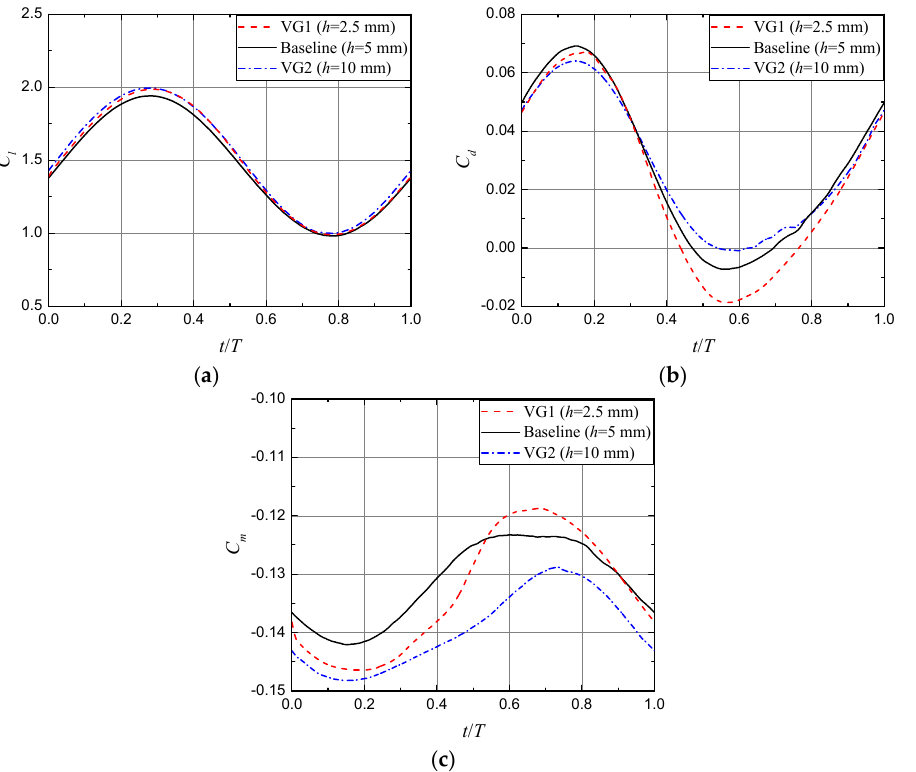
Figure 15. Unsteady aerodynamic coefficients of the airfoil with different VGs in vane height. α mean = 10 ° , A = 5 ° , and k = 0.055: ( a ) C l ; ( b ) C d ; ( c ) C m .